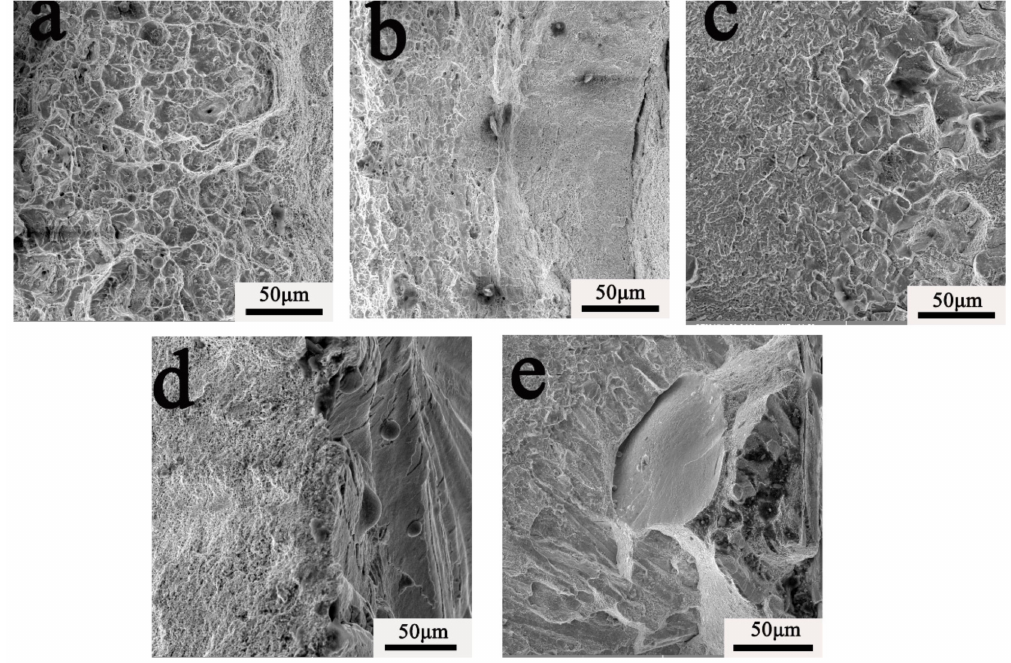
Figure 13. Fracture surfaces of the units: ( a ) LR-A1, ( b ) LR-A2, ( c ) LR-A3, ( d ) LR-A4, and ( e )